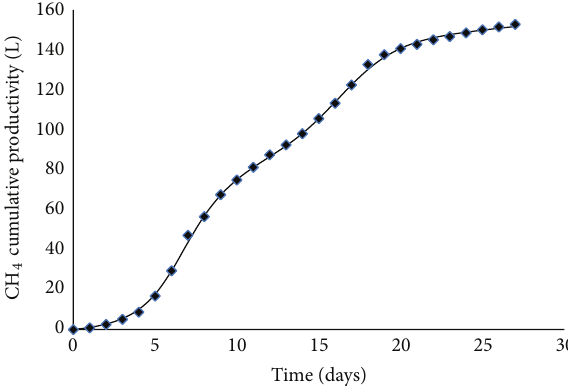
Figure 8: Effect of the variation of feed mixture composition on methane cumulative